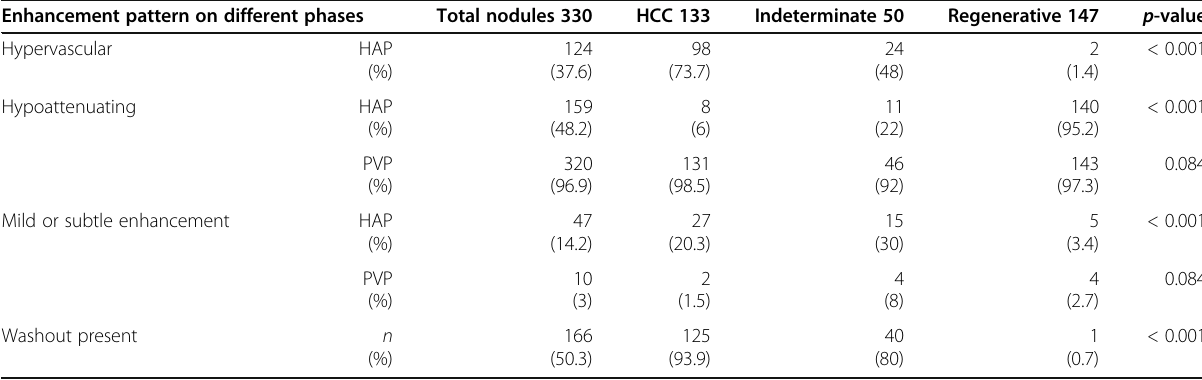
Table 3 Enhancement pattern of nodules on computed tomography Enhancement pattern on different phases Total nodules